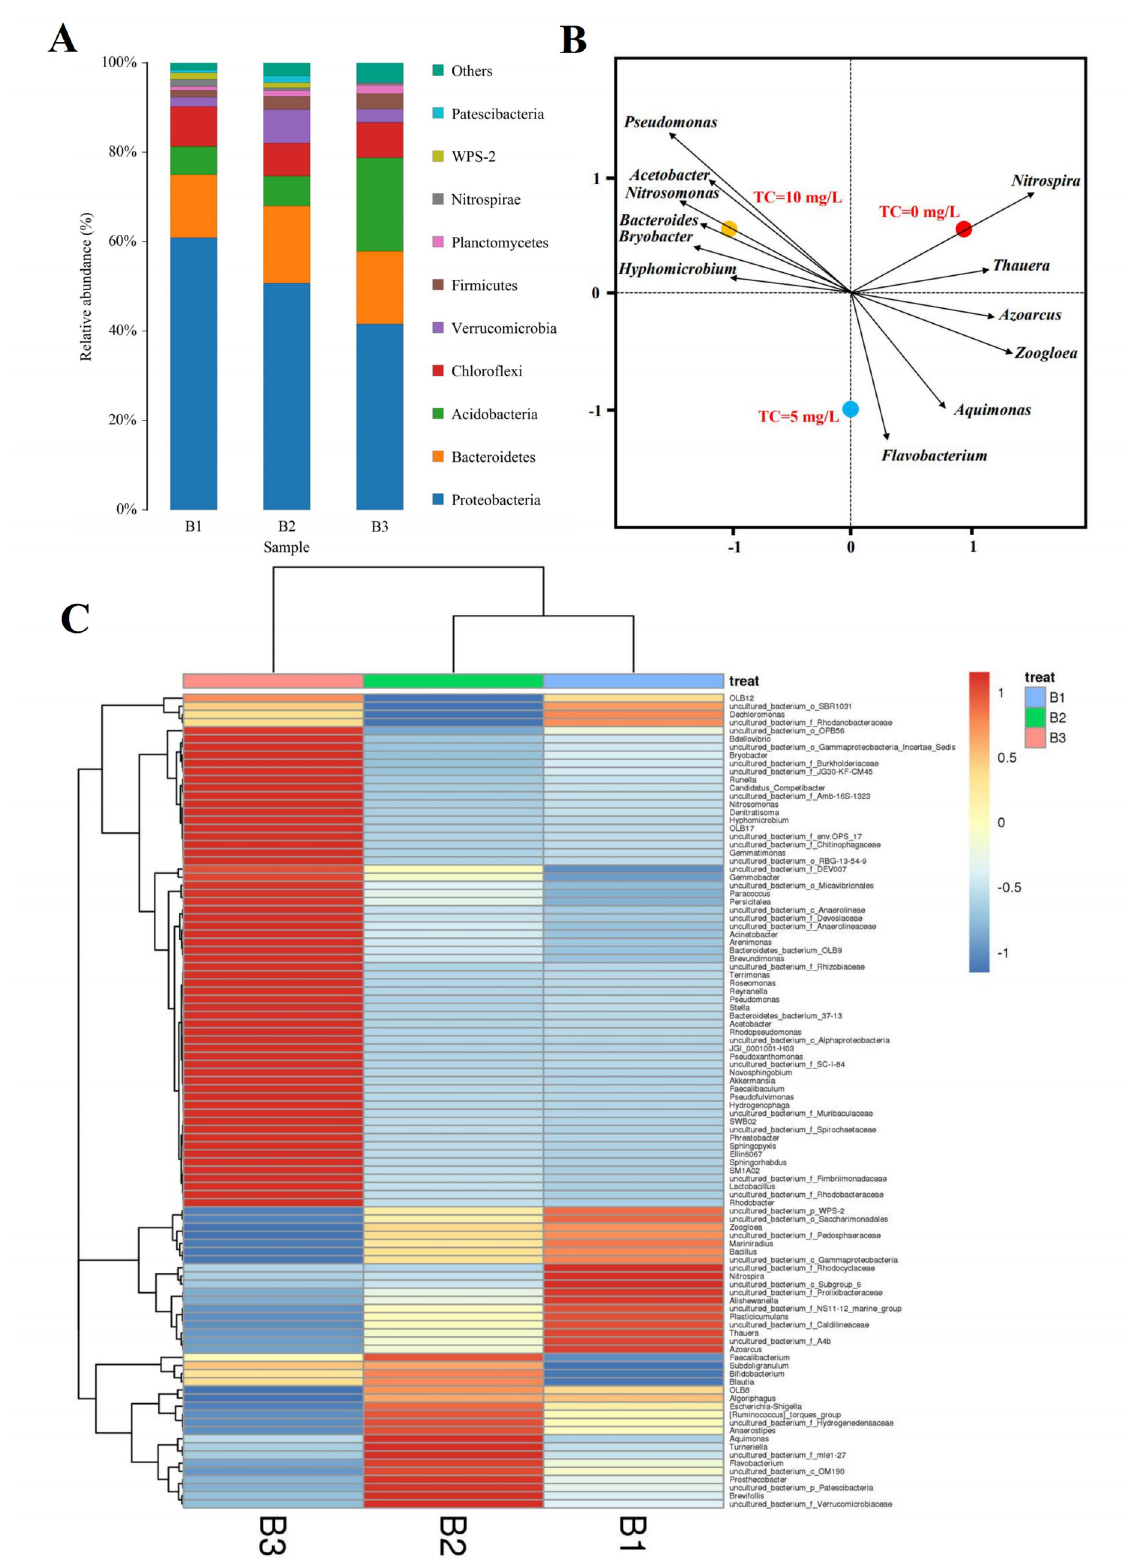
Fig 2. Classification of microorganisms in the MBBR: bacterial community at phylum-level (A); heatmap of genus level (B); RDA ordination analysis of the correlation between frequent species dynamics and the samples (C). https://doi.org/10.1371/journal.pone.0261306.g002 PLOS ONE | https://doi.org/10.1371/journal.pone.0261306 January 10,